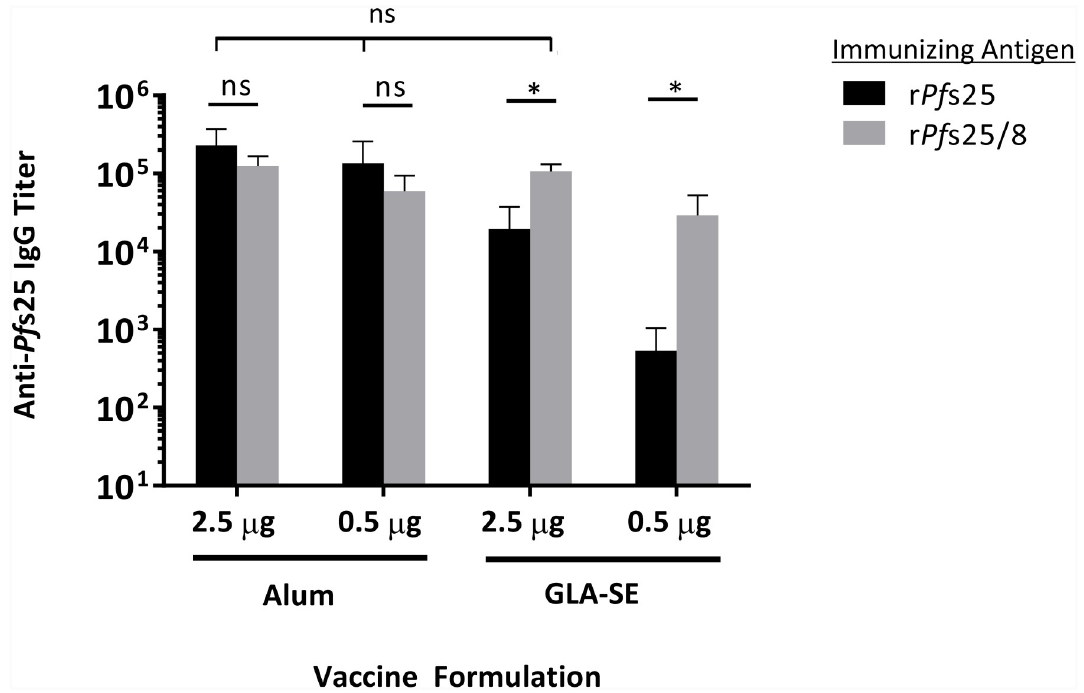
Fig 5. Final anti- Pf s25 IgG titers induced by immunization with r Pf s25 and r Pf s25/8 as a function of dose and adjuvant. Direct comparison of final anti- Pf s25 IgG titers induced by r Pf s25 vs chimeric r Pf s25/8 antigens when formulated as indicated. Graphs depict the mean IgG titers +/- standard deviation. Comparisons of two groups differing only by antigen identity were conducted and significant differences are indicated by asterisks over horizontal lines (Mann-Whitney U Test; P < 0.05 considered significant). Comparisons of three or more groups were conducted as indicated and no significant differences were found (Kruskal Wallis Test, P < 0.05 considered significant; ns, not